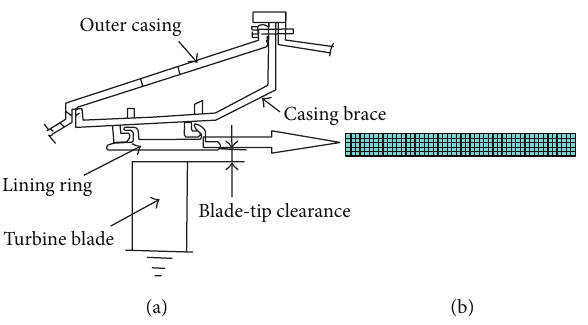
Figure 1: High pressure turbine structure (a) BTRRC sketch and (b) FE model of turbine casing.